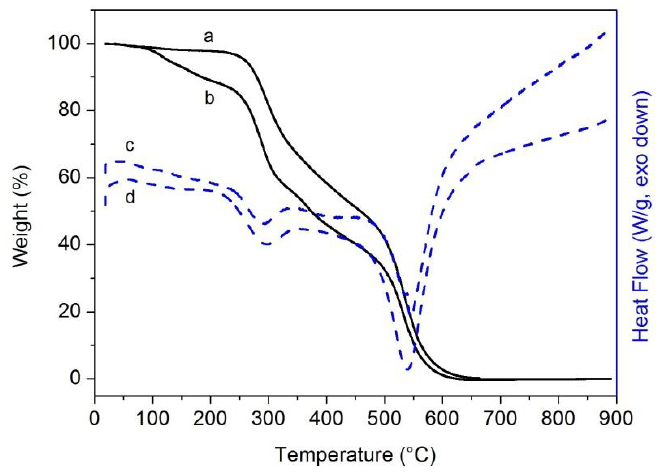
Figure 2. TGA (continuous lines) and DSC (dashed lines) curves of Epojet ® (a,c) and EpojetLV ® (b,d) resins cured at room temperature for seven days in 99% relative humidity